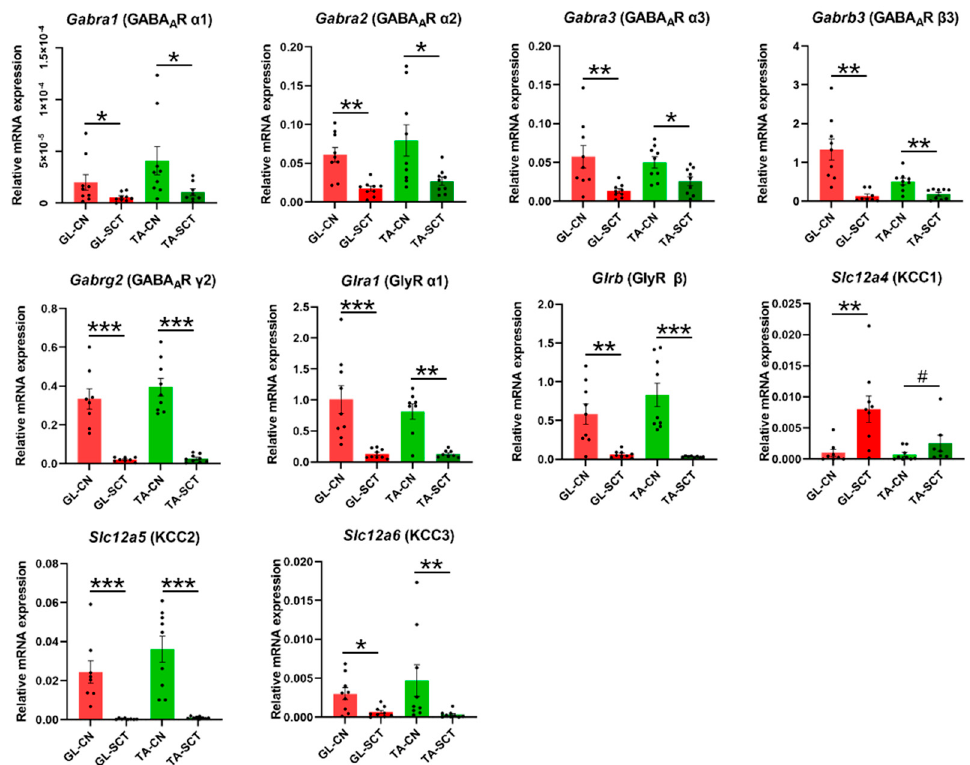
Figure 4. SCT downregulates the transcript level of all subunits of GABA A and Gly receptors, as well as KCC2 and KCC3 transporters, with the same impact on GL and TA MNs. The opposite response was found for the KCC1 transporter, both in GL and TA MNs. Data are means +/ − SEM. Mann-Whitney U -test, # p = 0.072; * p < 0.05; ** p < 0.01; *** p < 0.001. SCT caused a significant downregulation of Slc12a5 (KCC2) and Slc12a6 (KCC3)